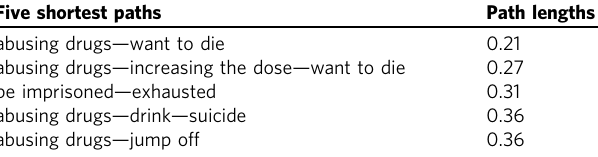
Table 2 The shortest paths and their lengths. Five shortest